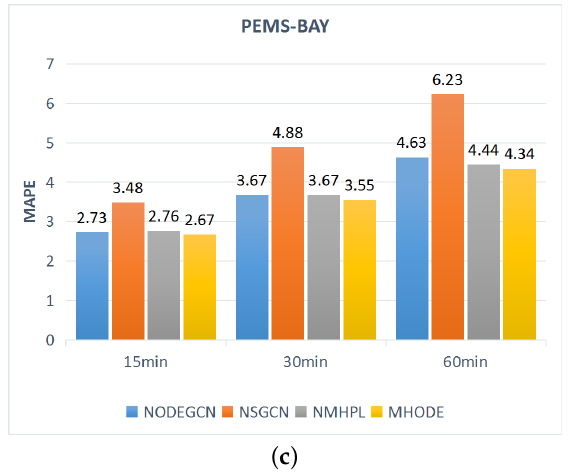
Figure 7. Experimental results for different variant models: ( a ) the MAE of the variant model on PEMS-BAY; ( b ) the RMSE of the variant model on PEMS-BAY; ( c ) the MAPE of the variant model on PEMS-BAY.